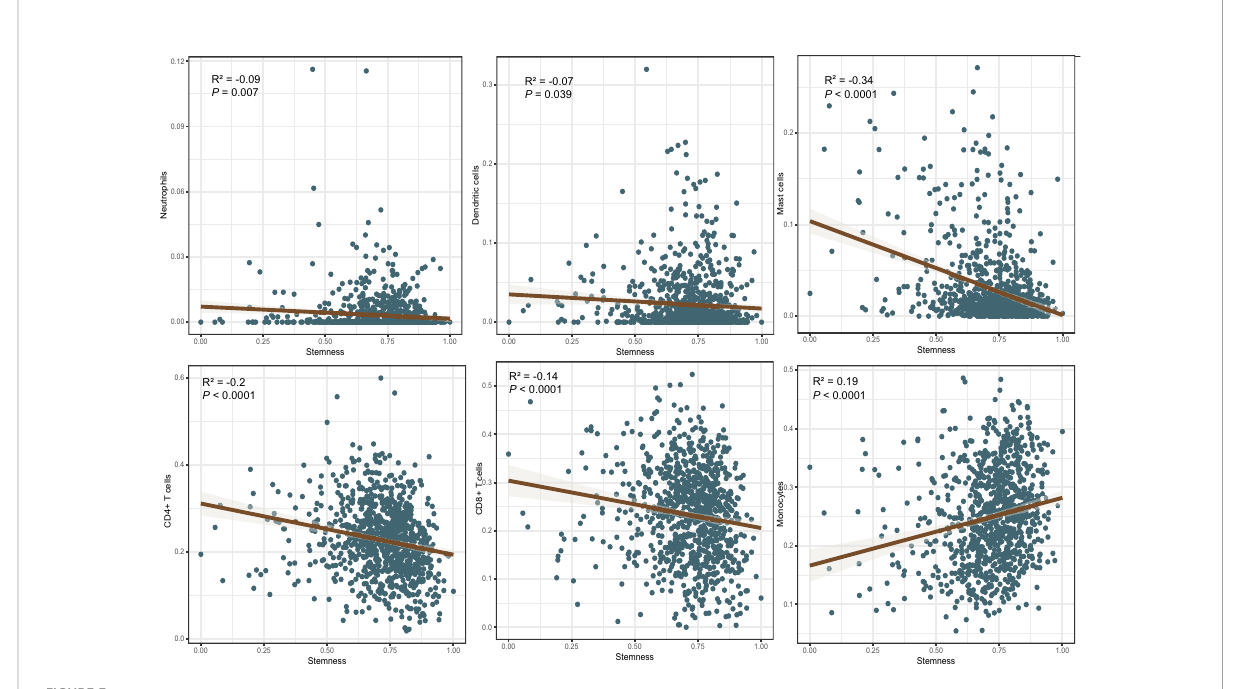
FIGURE 3 Correlations between the degree of stemness and immune cell